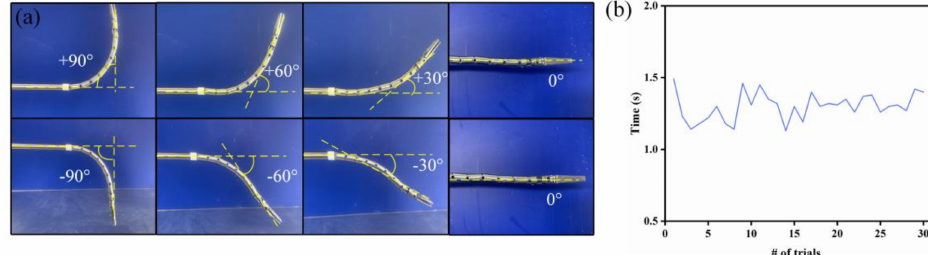
Figure 7. Demonstration of flexible instrument bending motion: ( a ) demonstration of the flexible instrument’s bending motion; ( b ) thirty degrees of response time per movement.